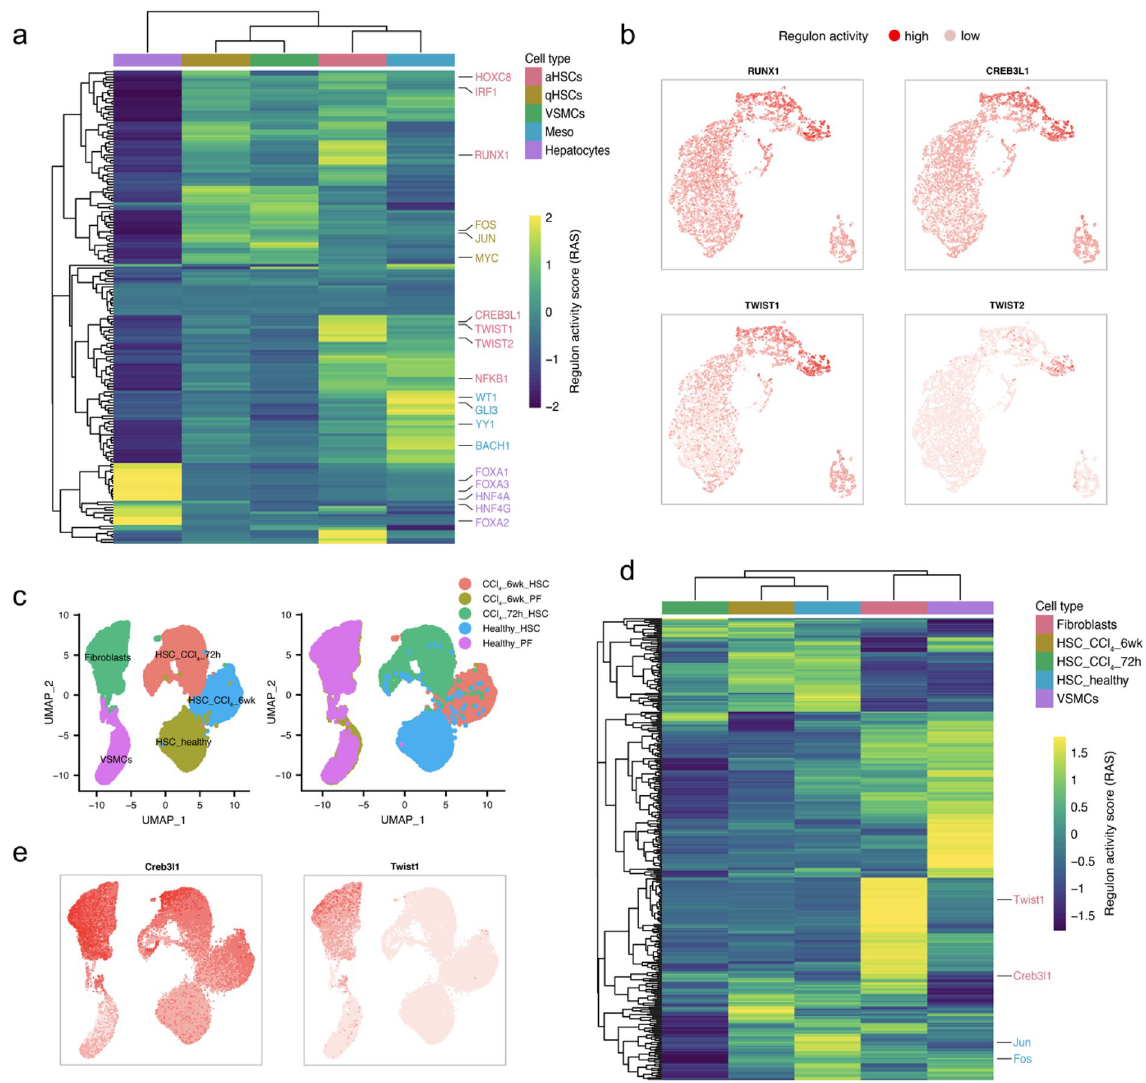
Figure 3. Cell type-specific gene regulatory networks (regulons) of liver mesenchymal cells. ( a ) Heatmap of the inferred regulons for human liver mesenchymal cells. ( b ) Regulon activity-based UMAP colored according to the regulon activity of CREB3L1, RUNX1, TWIST1 and TWIST2 showing the cell type specificity of regulons. ( c ) UMAP embedding of mouse liver mesenchymal cells from uninjured and fibrotic (up to 6 weeks of CCl 4 treatment) mouse livers retrieved from Dobie et al. (2019). Left, cells colored by cell type/state. Right, cells colored by condition/cell origin. ( d ) Heatmap of the inferred regulons for mouse liver mesenchymal cells. ( e